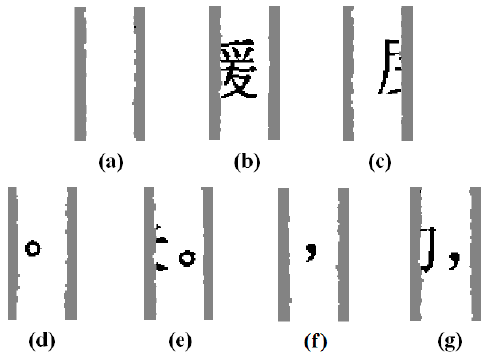
Figure 6. Four types of blocks: ( a ) a type I block; ( b ) a type II block; ( c ) a type II block; ( d ) a type III block; ( e ) a type III block; ( f ) a type IV block; ( g ) a type IV block.